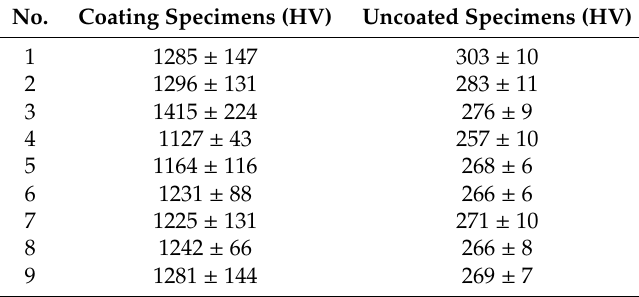
Table 3. Microhardness value of specimens.